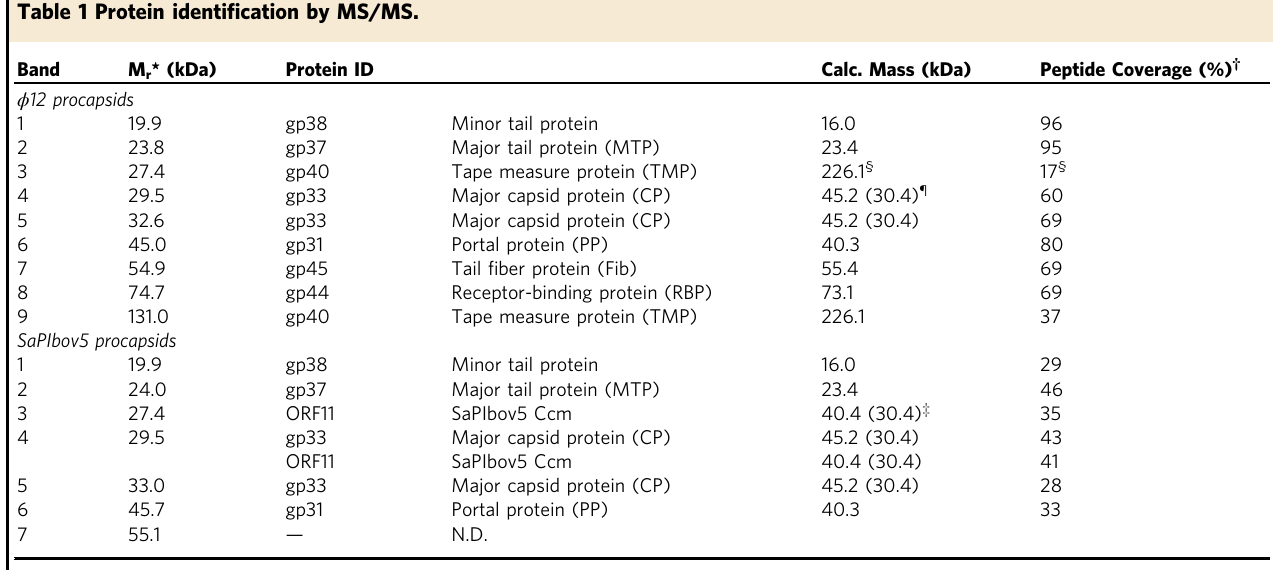
Peptide coverage was calculated in Scaffold using a 95% con fi dence level.